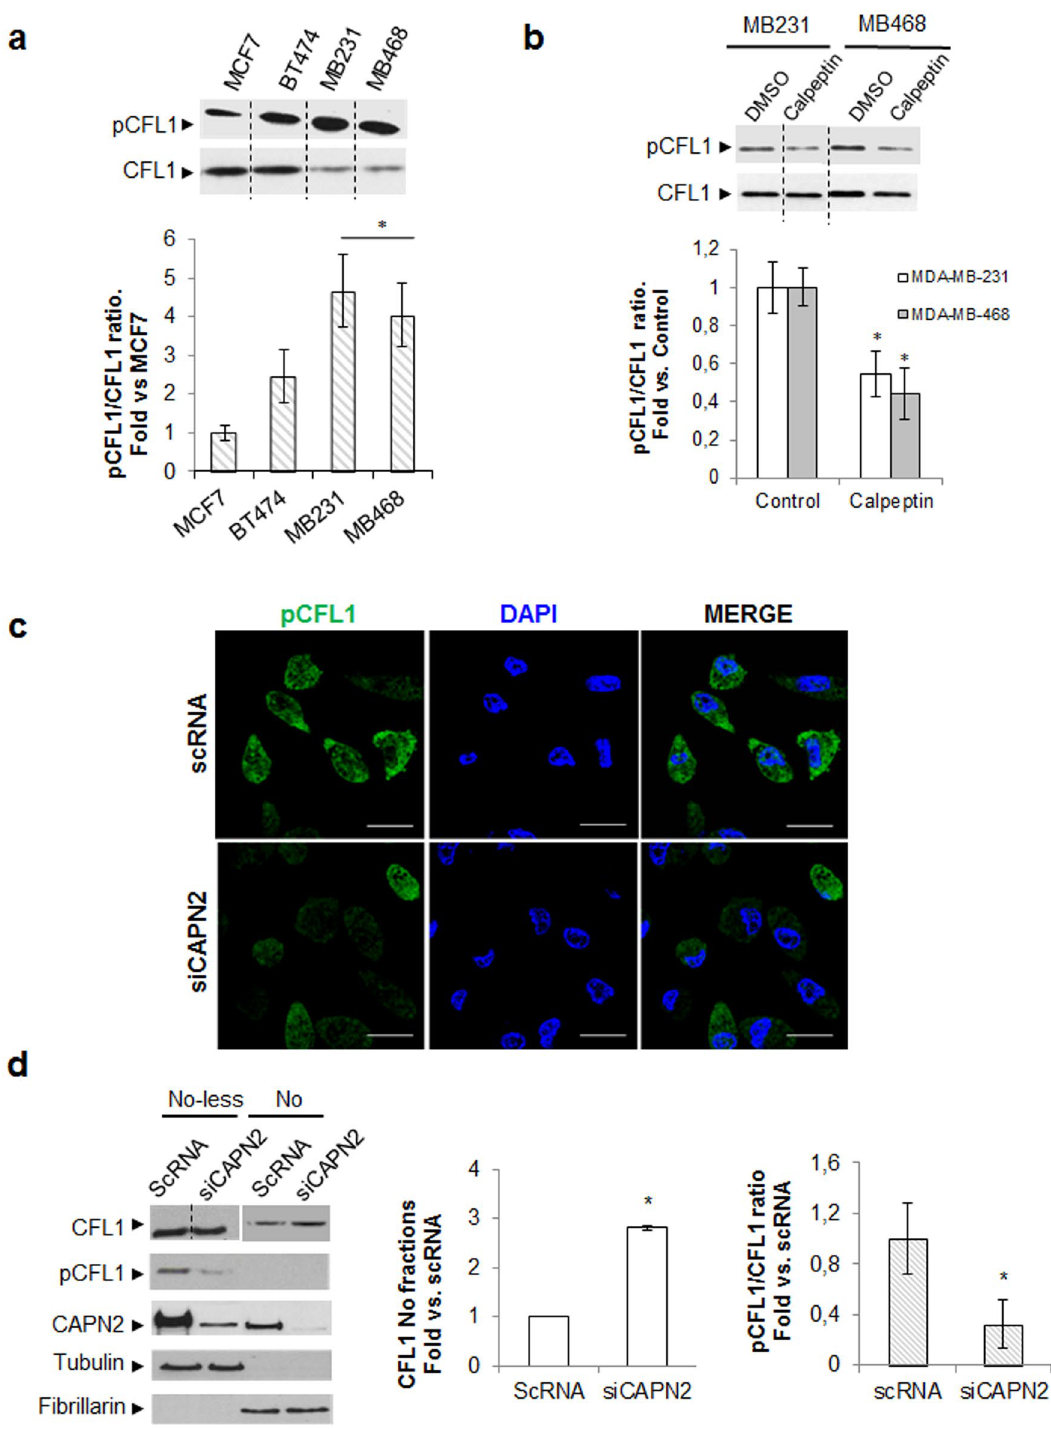
Figure 4. Effect of CAPN2 expression in Cofilin-1 phosphorylation rate and subnuclear distribution. ( a ) Immunoblots of pCFL1 and CFL1 in whole extracts from BCC cell lines. Data (n ≥ 3) were quantified and represented as the ratio pCFL1/CFL1 mean fold ± SEM. *p ≤ 0.01 vs. MCF7 cells. ( b ) Immunoblots of pCFL1 and CFL1 in whole protein extracts from TNBC cells (n = 3) cultured for 24 h in the presence of vehicle (DMSO) or 50 μM calpeptin. Data (n ≥ 3) were quantified and the ratio pCFL1/CFL1 represented as mean fold ± SEM vs. DMSO-treated cells. *p ≤ 0.01. ( c ) Immunofluorescence staining of pCFL1 (green) and DAPI (blue) in MDA-MB-231 cells transfected with scRNA/ siCAPN2 (n = 6). Scale bars 20 μm. ( d ) Subnuclear distribution of CFL1 and pCFL1 analyzed by western blot in nucleolar (No) and nucleolar-less fractions (No-less) from MDA-MB-231 cells transfected with scRNA/siCAPN2. Data (n ≥ 3) were quantified, normalized with fibrillarin (No) or tubulin (No-less), and plotted as nucleolar CFL1 mean fold ± SEM vs. scRNA transfected-cells *p ≤ 0.01 or as the ratio pCFL1/CFL1 mean fold ± SEM. *p ≤ 0.05 vs. scRNA transfected-cells. Juxtaposed images from different lanes in the same blot are separated by dotted lines in ( a , b , d ). Full- length blots are presented in Supplementary Fig.